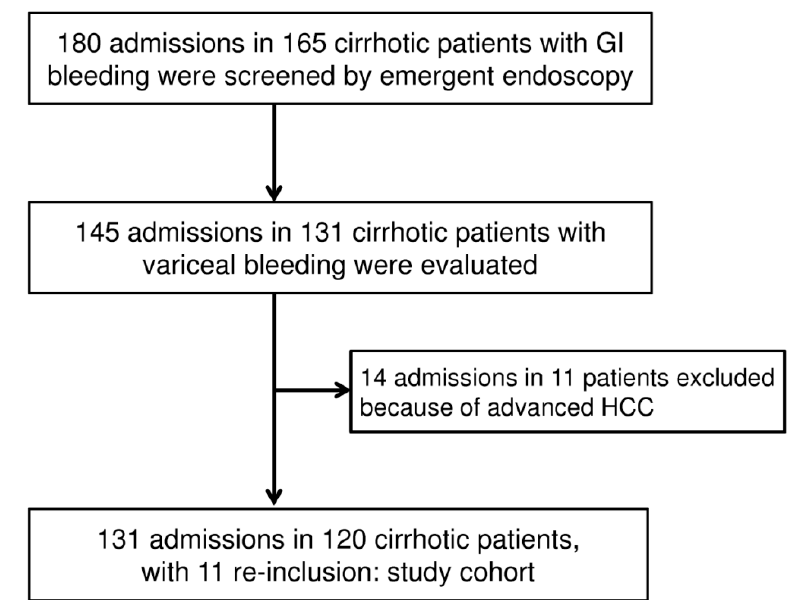
Figure 1. Diagram showing the flow of patients included in the study cohort. In 10 cases of study cohort, variceal bleeding episode occurred during the period of being hospitalized.